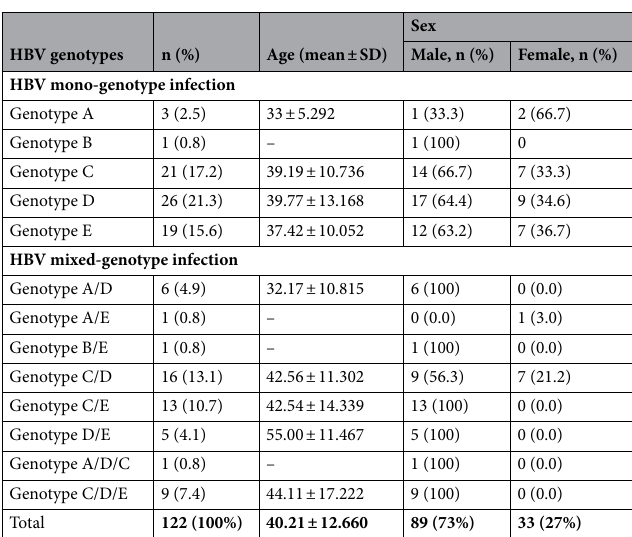
Table 3. Summary and distribution of HBV genotypes among liver disease patients with HBV in Eritrea. (–) Mean and SD cannot be computed because there was only one patient each with genotype B, A/E, B/E, and A/D/C.